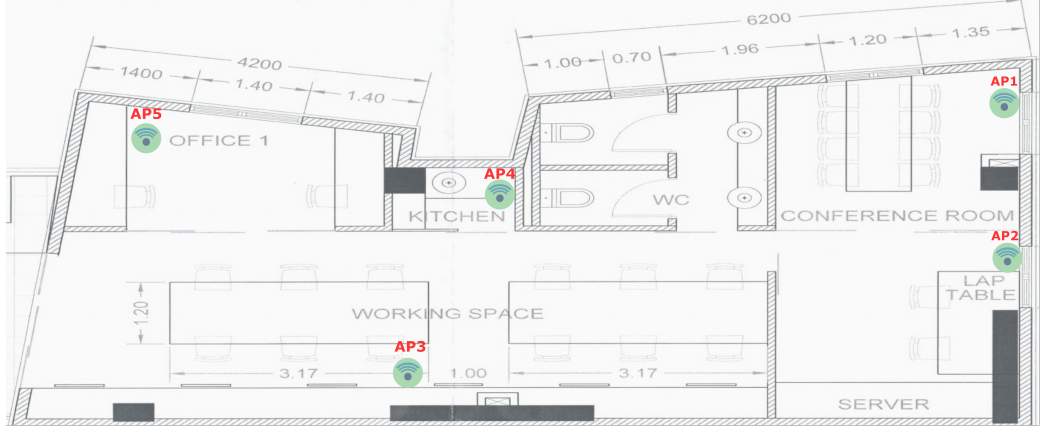
Figure 8. Access points position on the setup environment